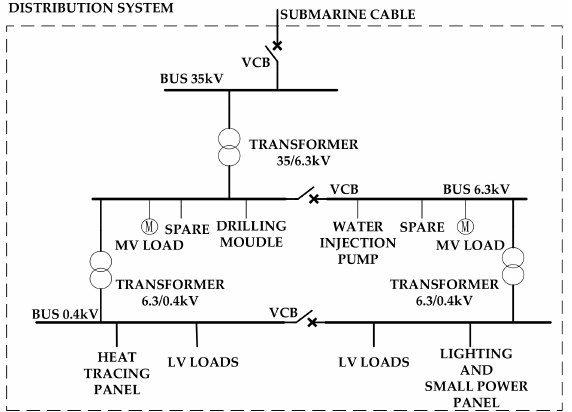
Figure 3. Schematic diagram of a typical distribution system.